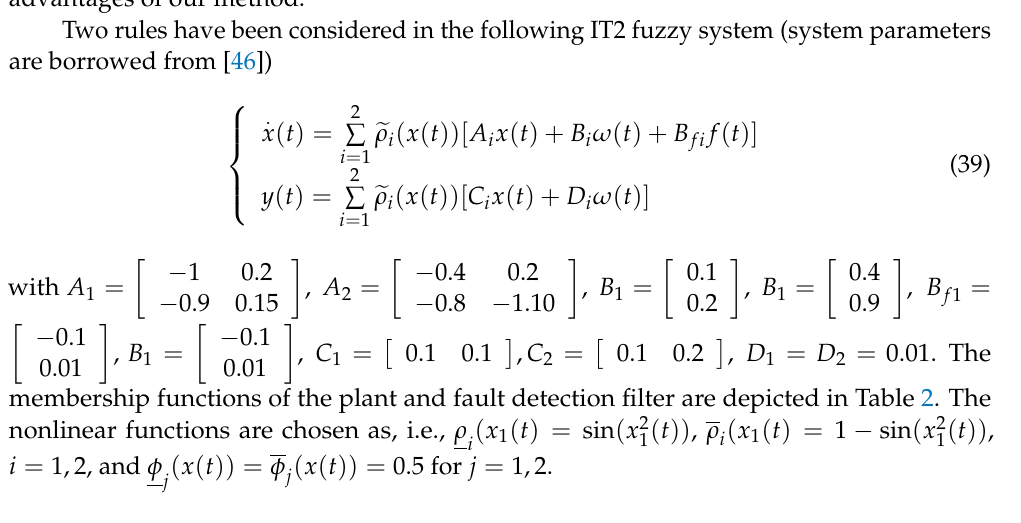
Table 2. Membership functions for plant and filter. The Upper Membership